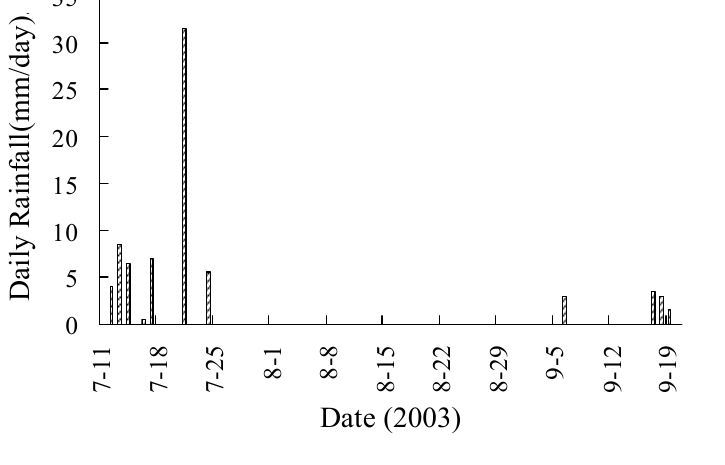
Figure 10. Daily rainfall within the half month just before Jul. 26 and Sep. 21 in